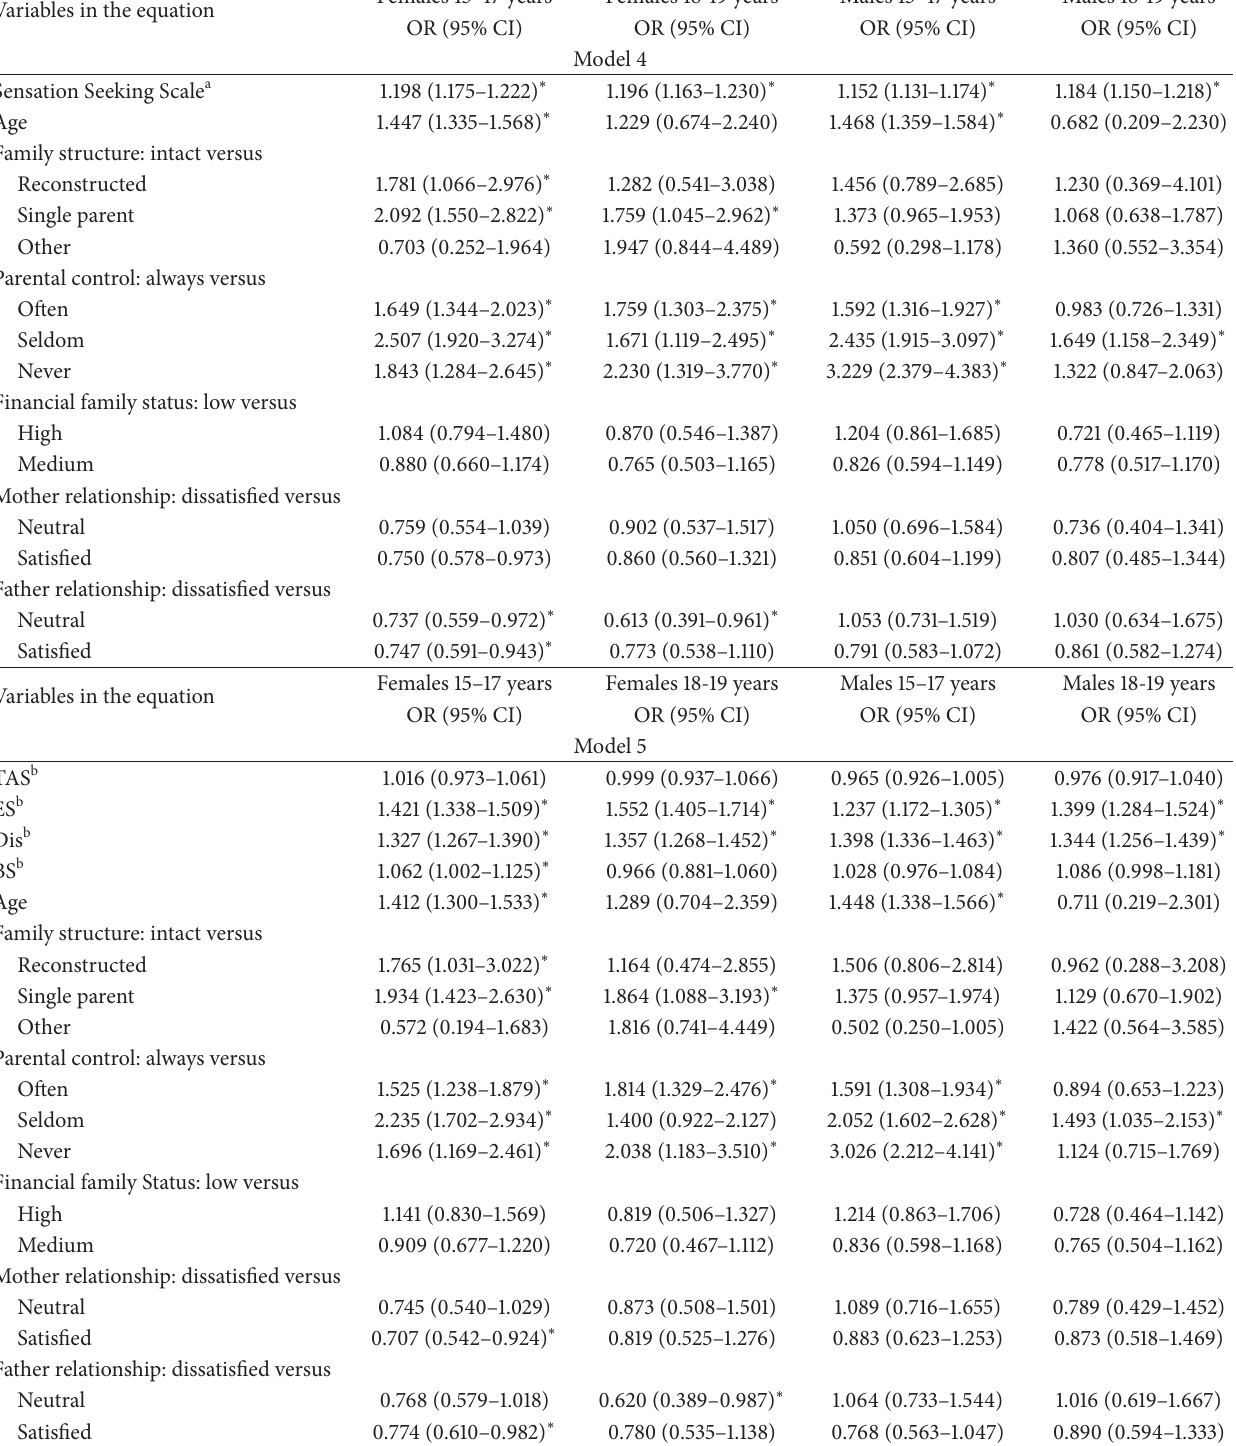
Table 5: Multivariate logistic model for substance use for gender and